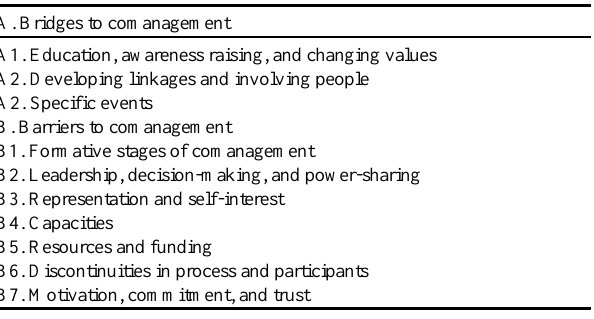
Table 2 . Stakeholder-perceived bridges and barriers to comanagement at Macassar Dunes, interpreted here as broad themes developed from 25 semistructured